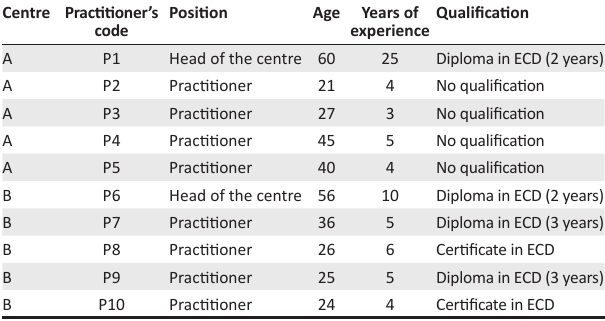
TABLE 1: Participants’ information. Centre Practitioner’s code